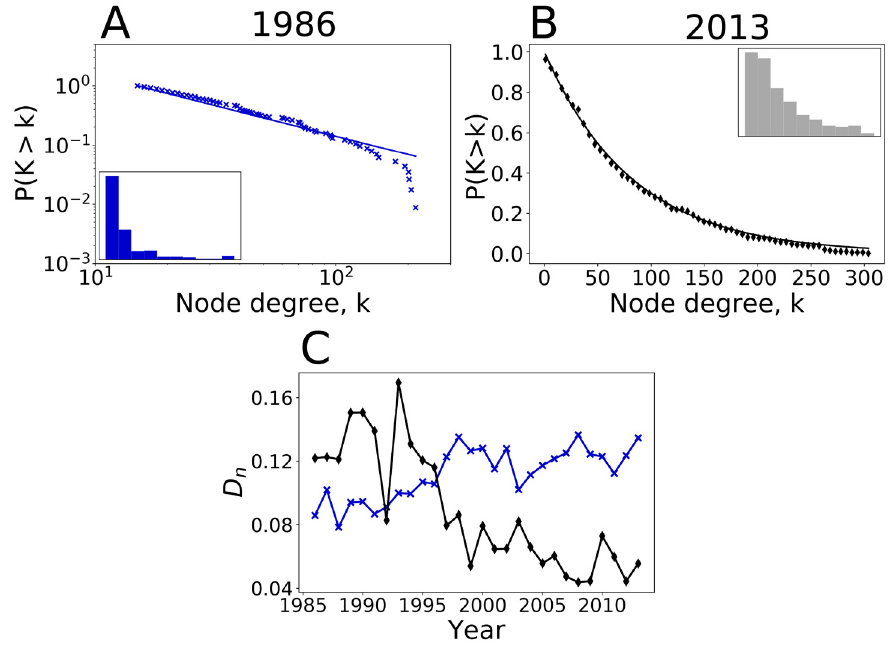
Fig 1. Evolution of the degree distribution of the world cereals trade network. A. Degree distribution in 1986 . The cumulative density function follows a power law of type P ( K > k ) / k − α ) with k Kolmogorov-Smirnov statistic is: D n = 0.0857. The power law property is a characteristic of a scale free network, the degree of a few nodes greatly exceeds the average degree of nodes. The highest-degree nodes are the “hubs”, and serve specific purposes in the networks, here they are major exporting countries. B. Degree distribution in 2013 . The cumulative density function fits with an exponential function of type P ð K > k Þ / exp ð(cid:0) k the average degree of nodes. C. Kolmogorov-Smirnov distance . The distance, D with a power law distribution (blue line) and with an exponential distribution (black line). The Kolmogorov-Smirnov statistic, D , gives the distance between the data and the fit. Minimizing this value equates to optimizing the fit. Until n 1996, the D n value was lower for the power law fit than for the exponential fit; the inverse is true after 1997. Thus, the fit of the power law becomes less accurate and the fit of the exponential distribution becomes more accurate. These two trends confirm the evolution of the degree distribution from scale free to